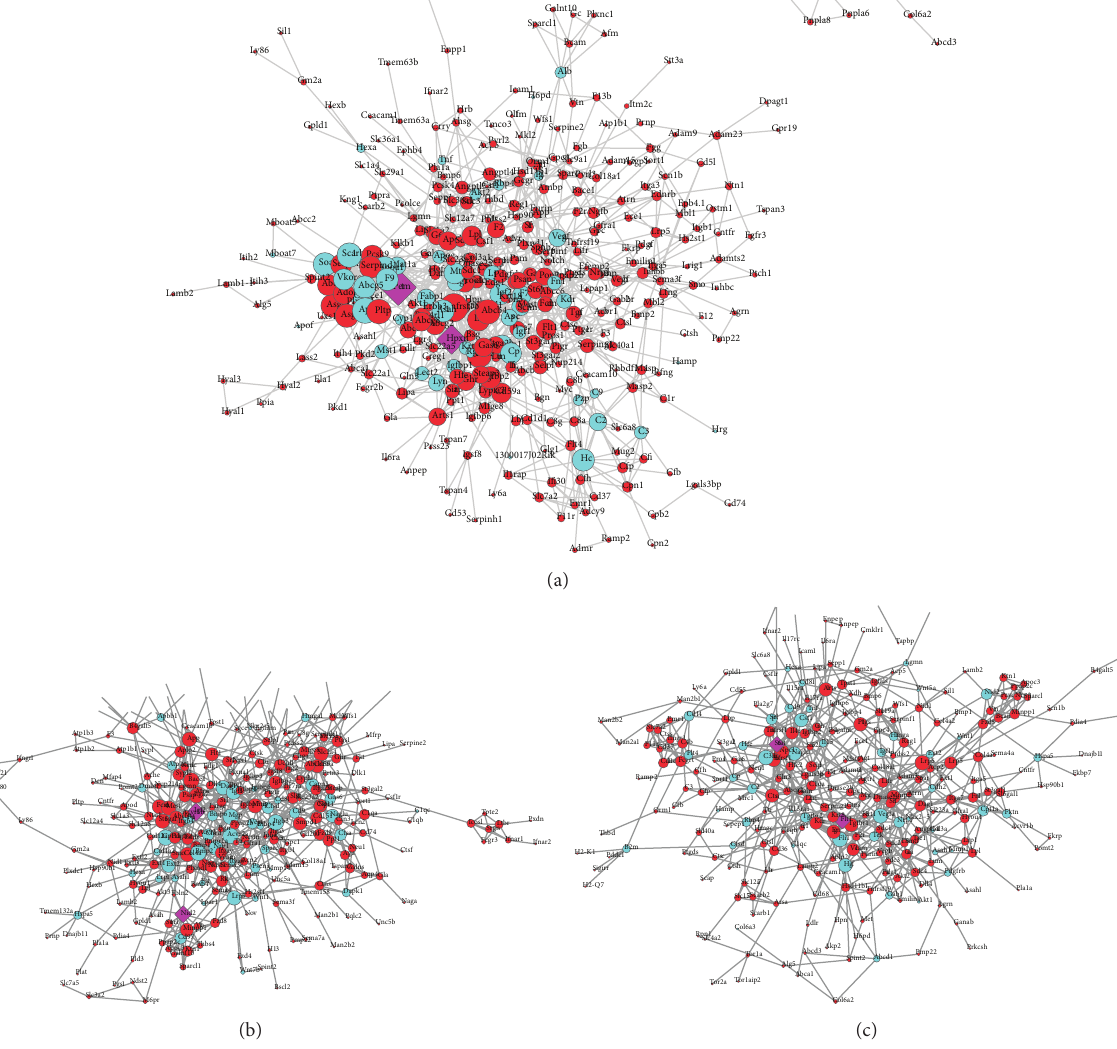
Figure 2: Interaction networks between DEGGs and additional related genes: (a) BvL579, (b) BvM501, and (c) LvM442. In each of these networks, red indicates a DEGG whereas the GeneMANIA predicted genes are shown in cyan. The top two hubs are shown as purple diamonds. The size of the nodes represents the node